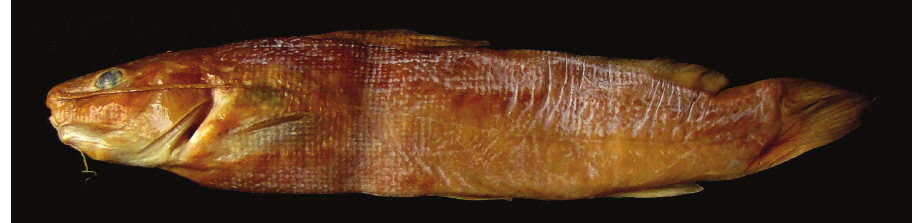
Fig. 4. Lateral view of holotype of Rhamdia branneri , FMNH 54235, 100.3 mm SL, Brazil, Paraná, Serrinha, rio